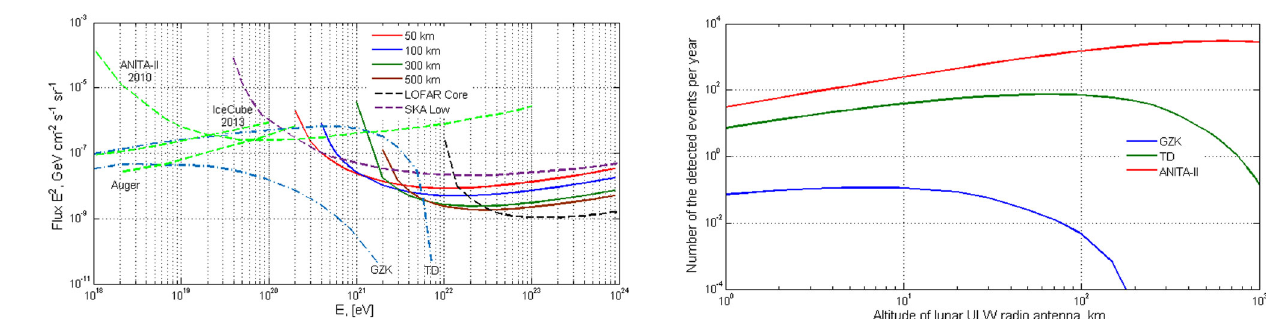
Fig. 9 The total number of detected (per year) neutrino events with the flux limits set by the ANITA-II experiment, and the predicted fluxes for the GZK neutrinos [20] and topological defects (TD) [20], as a function of the lunar antenna altitude in the energy E ≥ 10 18